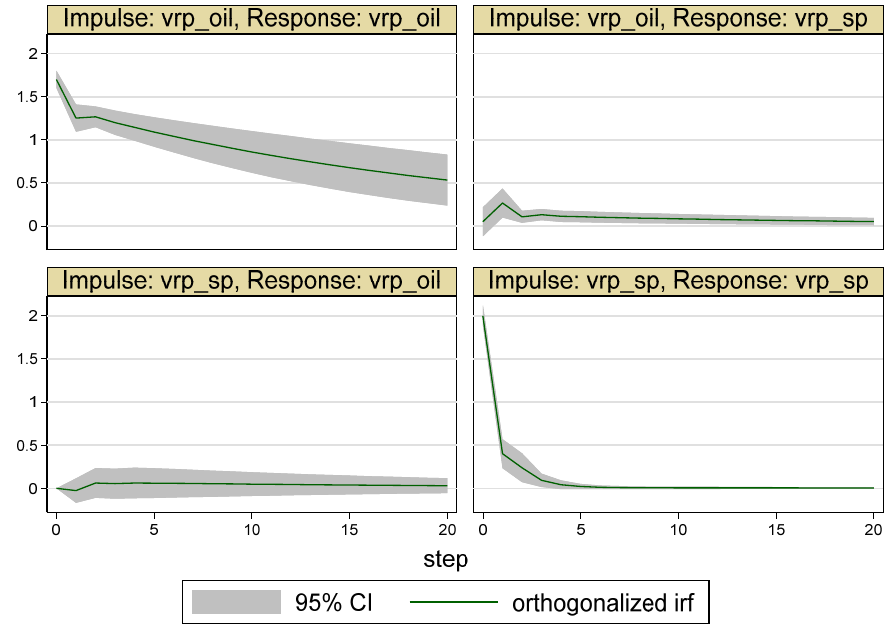
Figure 6. Impulse Response Function (Period 3).